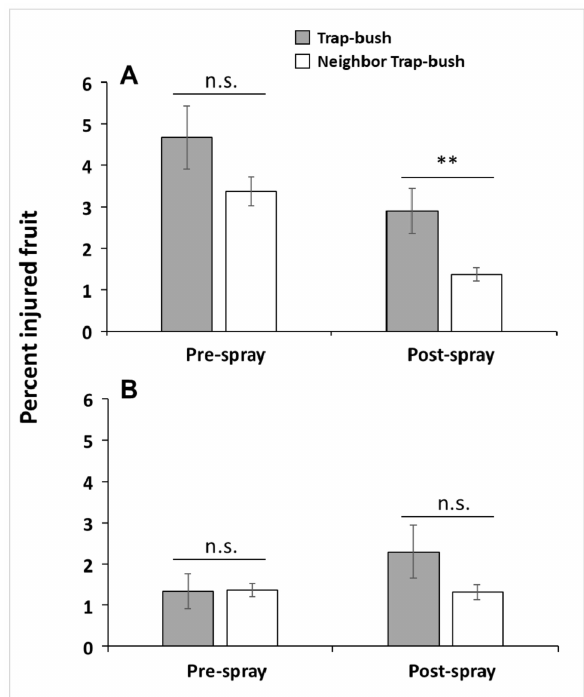
Figure 4. Percent (mean ± SE) of oviposition-scarred fruit by Conotrachelus nenuphar adults in trap bushes and in bushes neighboring trap bushes in 2013 ( A ) and 2014 ( B ). Fruit injury was assessed before and after a post-bloom insecticide application. Asterisks indicate significant di ff erences according to Welch’s two-sample t -test (** = p ≤ 0.01); n.s. = not significant ( p >